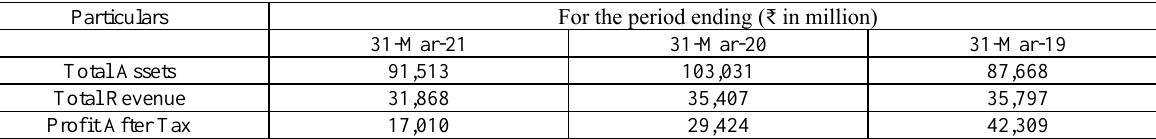
Table 1. Summary of Financial Information (Consolidated)